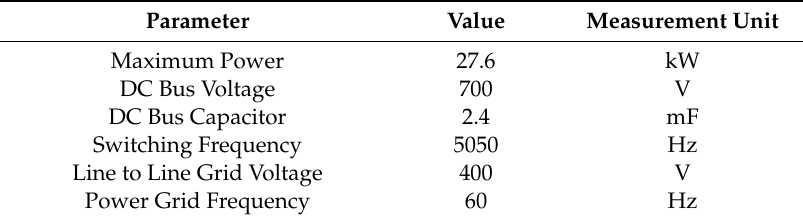
Table A5. Parameters of the DC-AC